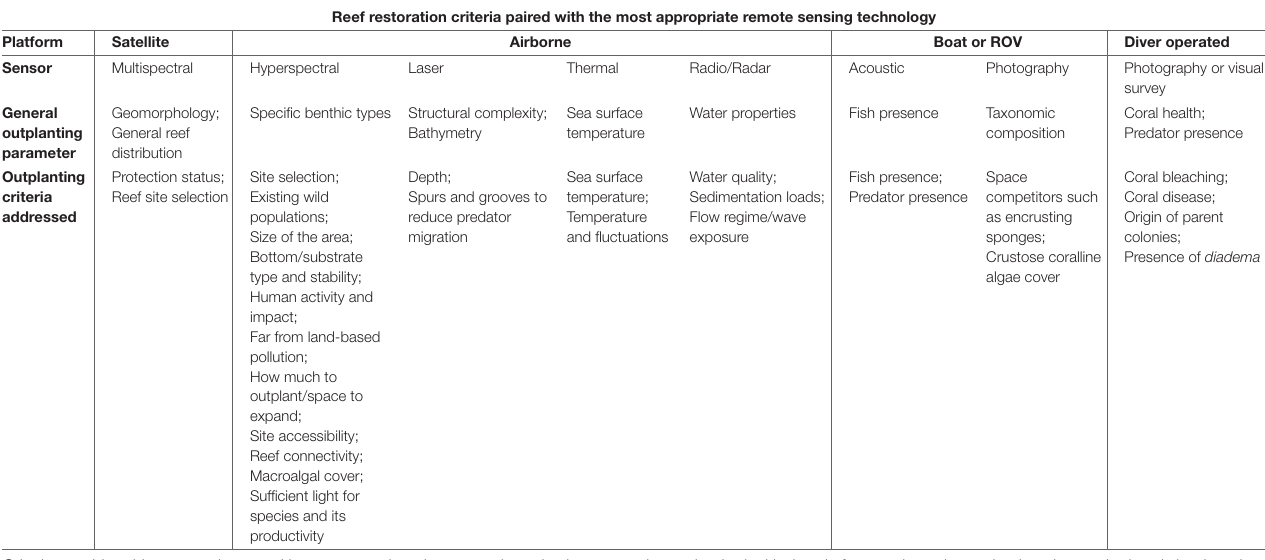
TABLE 1 | Remote sensing technologies and their application to informing coral reef outplanting and restoration success. Reef restoration criteria paired with the most appropriate remote sensing